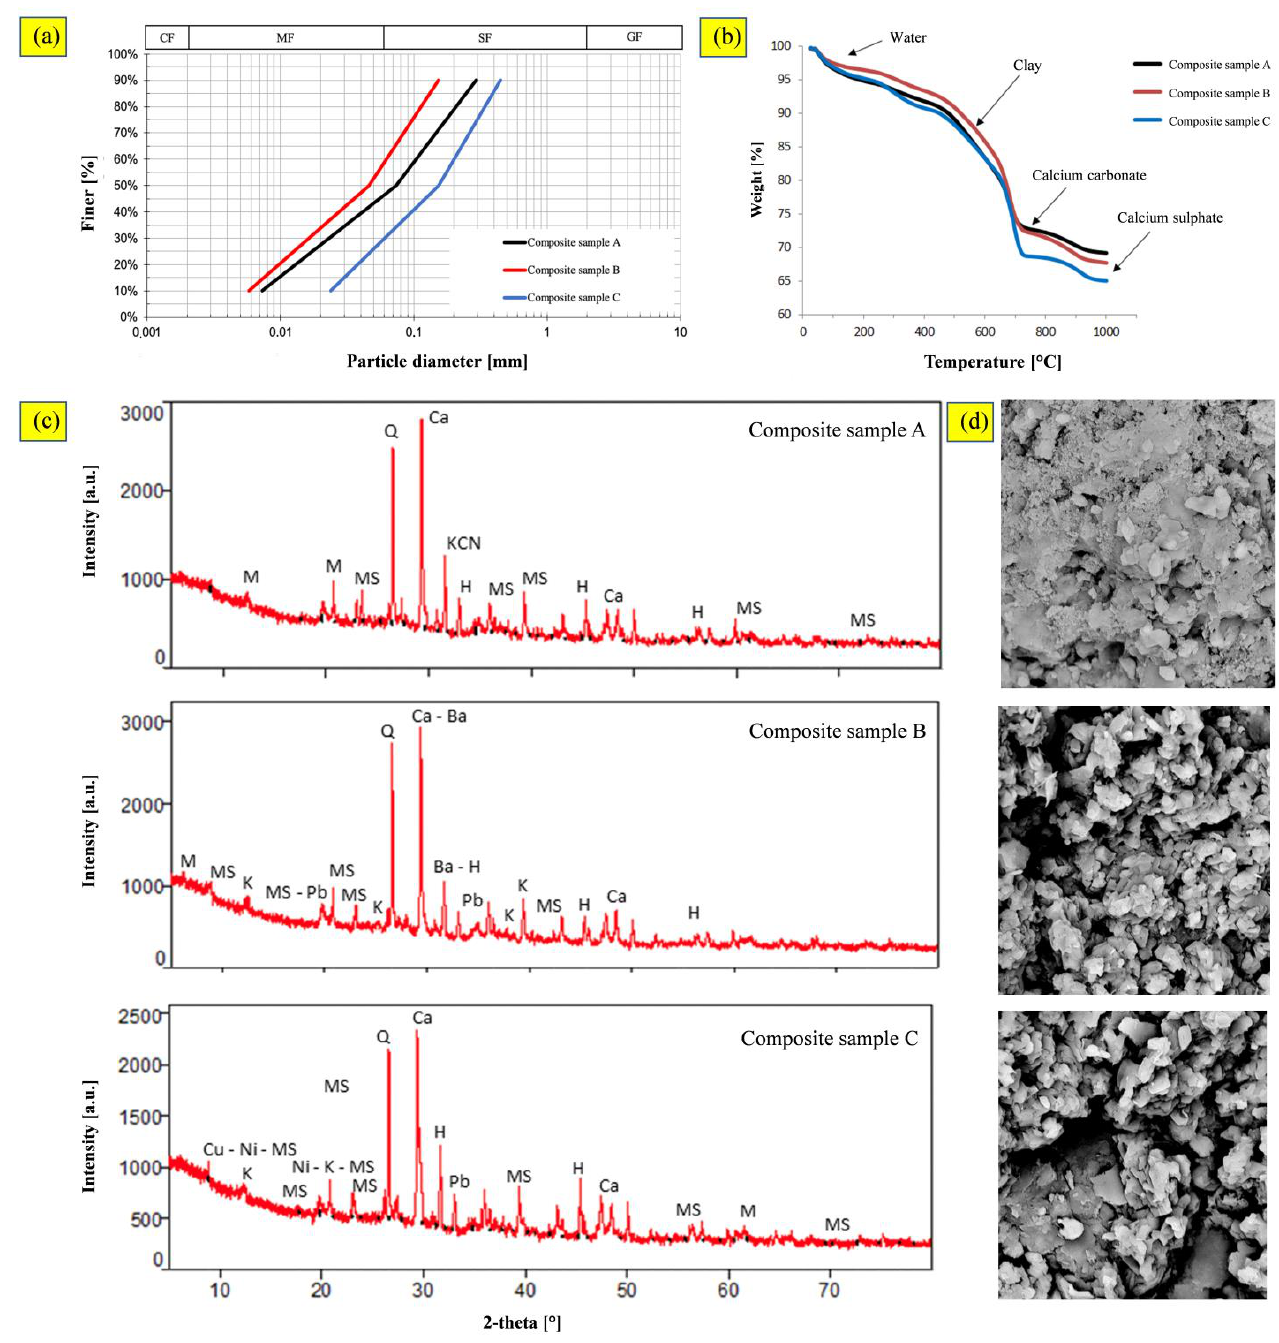
Figure 2. Sediments: ( a ) particle size distribution; ( b ) TGA curves; ( c ) XRD spectra; ( d ) SEM images (scale 10000:1).